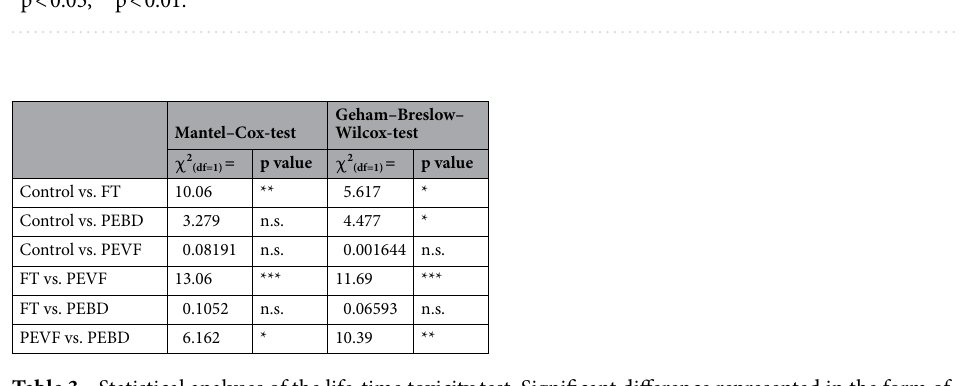
Table 3. Statistical analyses of the life-time toxicity test. Significant difference represented in the form of asterisks and p-value between the test groups. df denotes degrees of freedom, n.s . denotes no significant